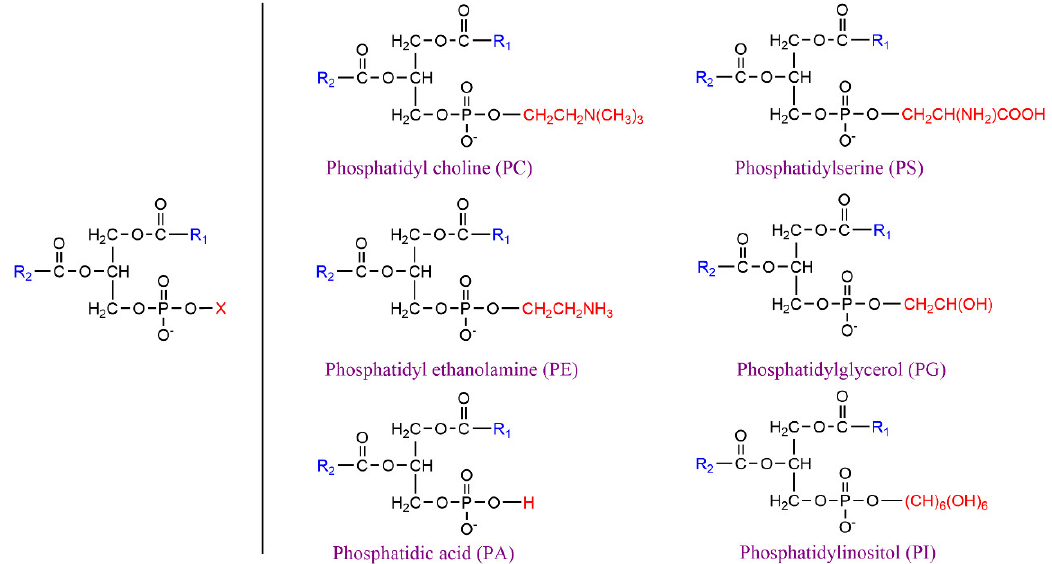
Figure 1. The molecular structures of phospholipids. The structure usually consists of glycerol, fatty acids (R 1 and R 2 ), a phosphate group, and a polar headgroup (X). The phosphoric acid linked to the sn –3 position of glycerol can be further esterified with various polar headgroups, such as choline, serine, ethanolamine, glycerol, hydrogen atom, or inositol, to form phosphatidylcholine (PC), phosphatidyl serine (PS), phosphatidyl ethanolamine (PE), phosphatidylglycerol (PG), phosphatidic acid (PA), or phosphatidylinositol (PI), respectively.